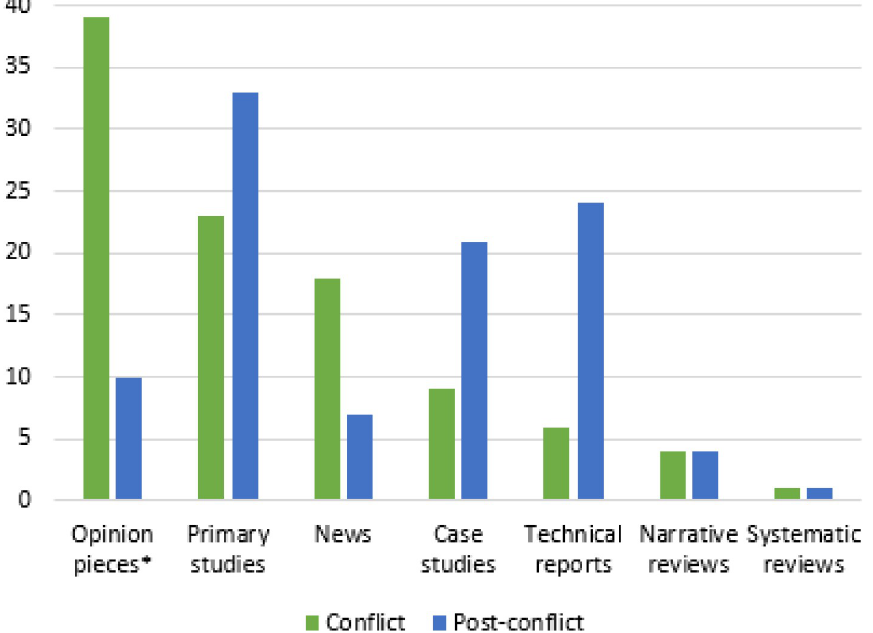
Fig 4. Types of publication � of the included papers on health care workers in conflict (N = 325) and post-conflict (N = 170) settings.